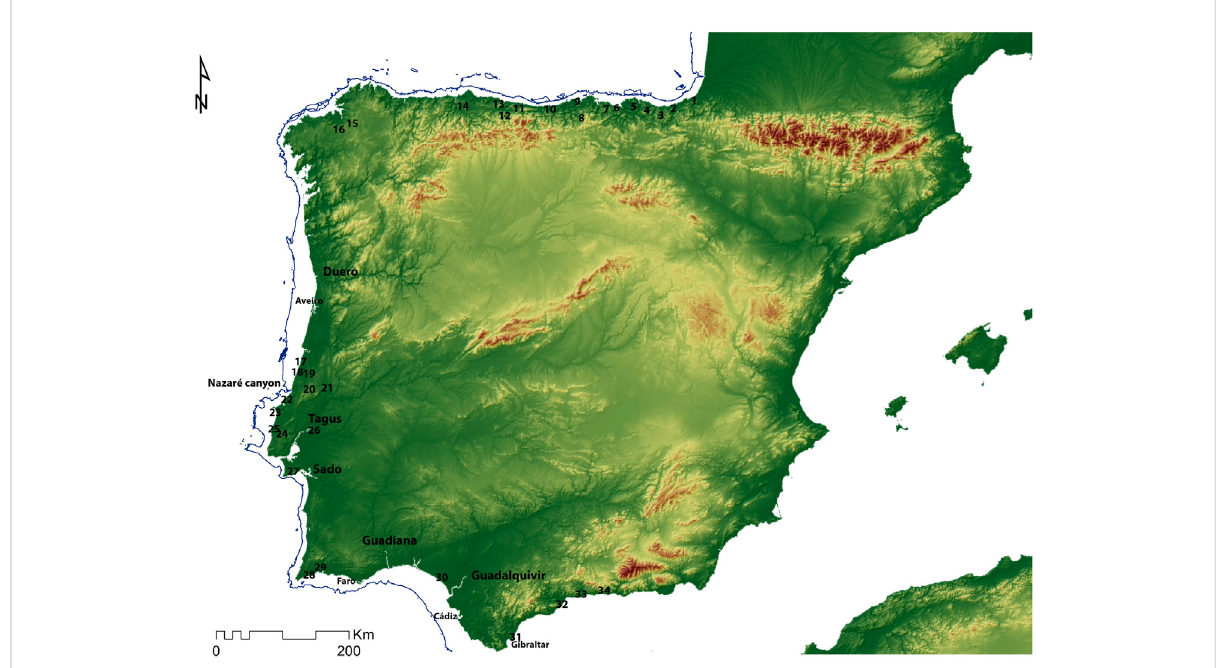
FIGURE 1 Map of Iberia with the main sites discussed in thetext. 1.Jaizkibel, 2. Altxerri, 3. Amalda, 4. Santimamine, 5. Toralete, 6. El Cuco, 7. El Pindal, 8. El Perro and La Garma, 9. El Juyo and Morín, 10. Altamira and El Salín, 11. La Riera, 12. El Castillo, 13. Tito Bustillo, 14. Las Caldas, 15. Pena Lliboi, 16. Xestido III, 17. Mira Nascente, 18. Praia do Pedrogão, 19. Lagar Velho, 20. Coelhos, Picareiro, and Anecrial, 21. Caldeirão, 22. Praia Rei Cortiço, 23. Furninha, 24. Suão, 25. Toledo, 26. Cabeço da Amoreira and Cabeço da Arruda, 27. Figueira Brava, 28. Vale Boi, 29. Companheira and Ibn Ammar, 30 Matalascañas, 31, Gorham ’ s and Vangard; 32. Bajondillo, 33. Humo, 34.